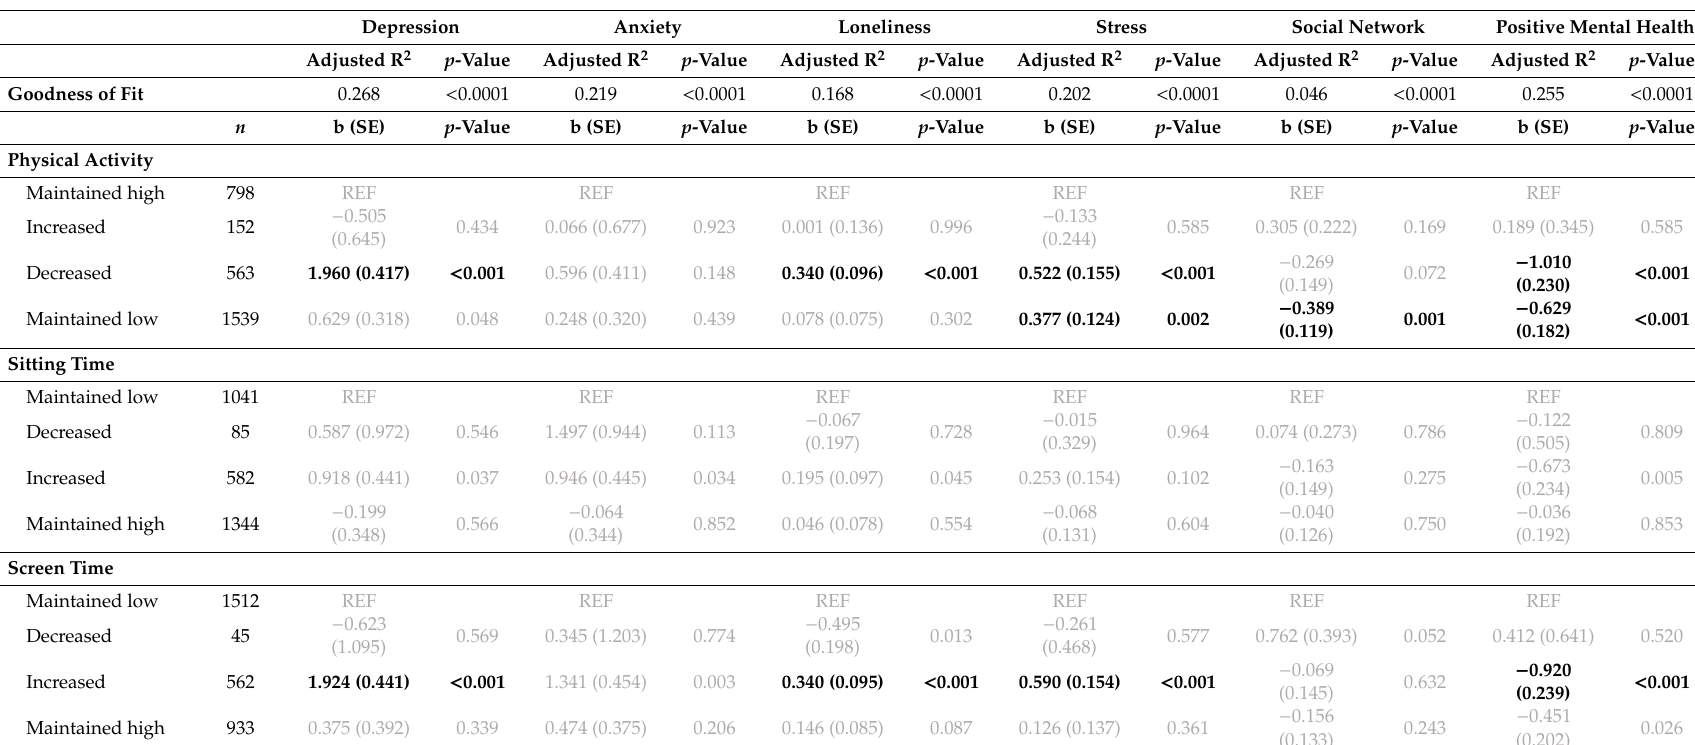
Table 2. Adjusted associations between self-reported changes in behavior from pre- to post-COVID-19-related restrictions and current mental health. Depression Anxiety Loneliness Stress Social Network Positive Mental